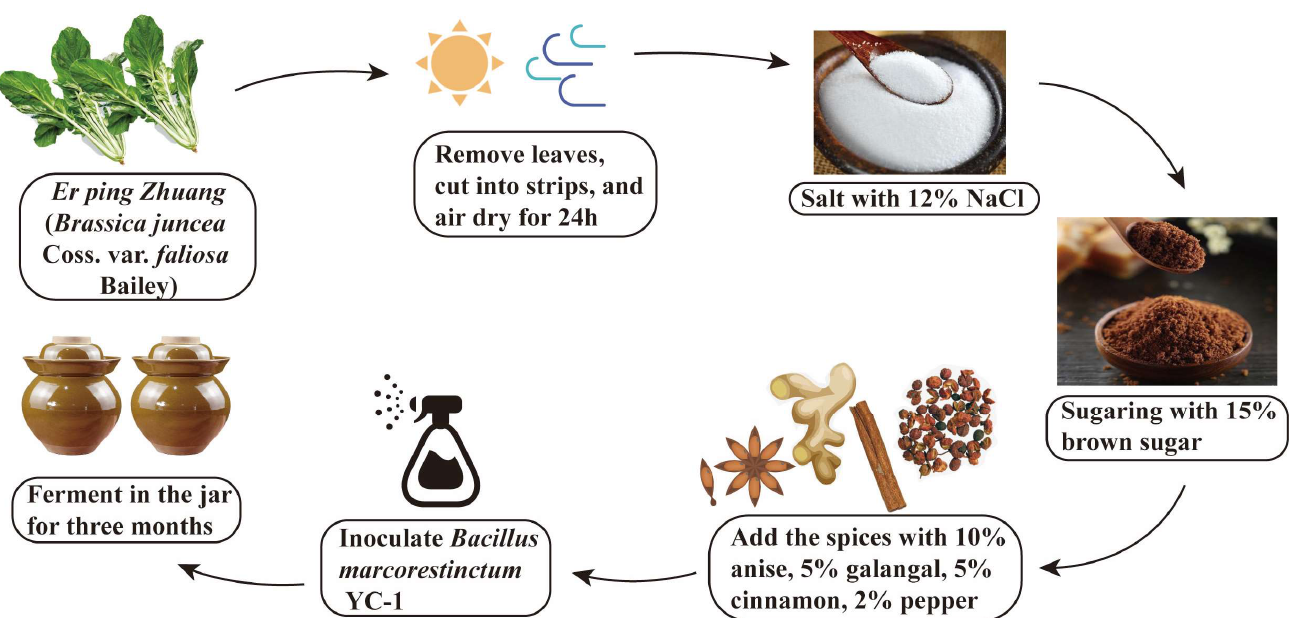
Figure 1. The main fermentation processes of Yibin Yacai inoculated with Bacillus marcorestinctum YC-1, based on the traditional fermentation processes.